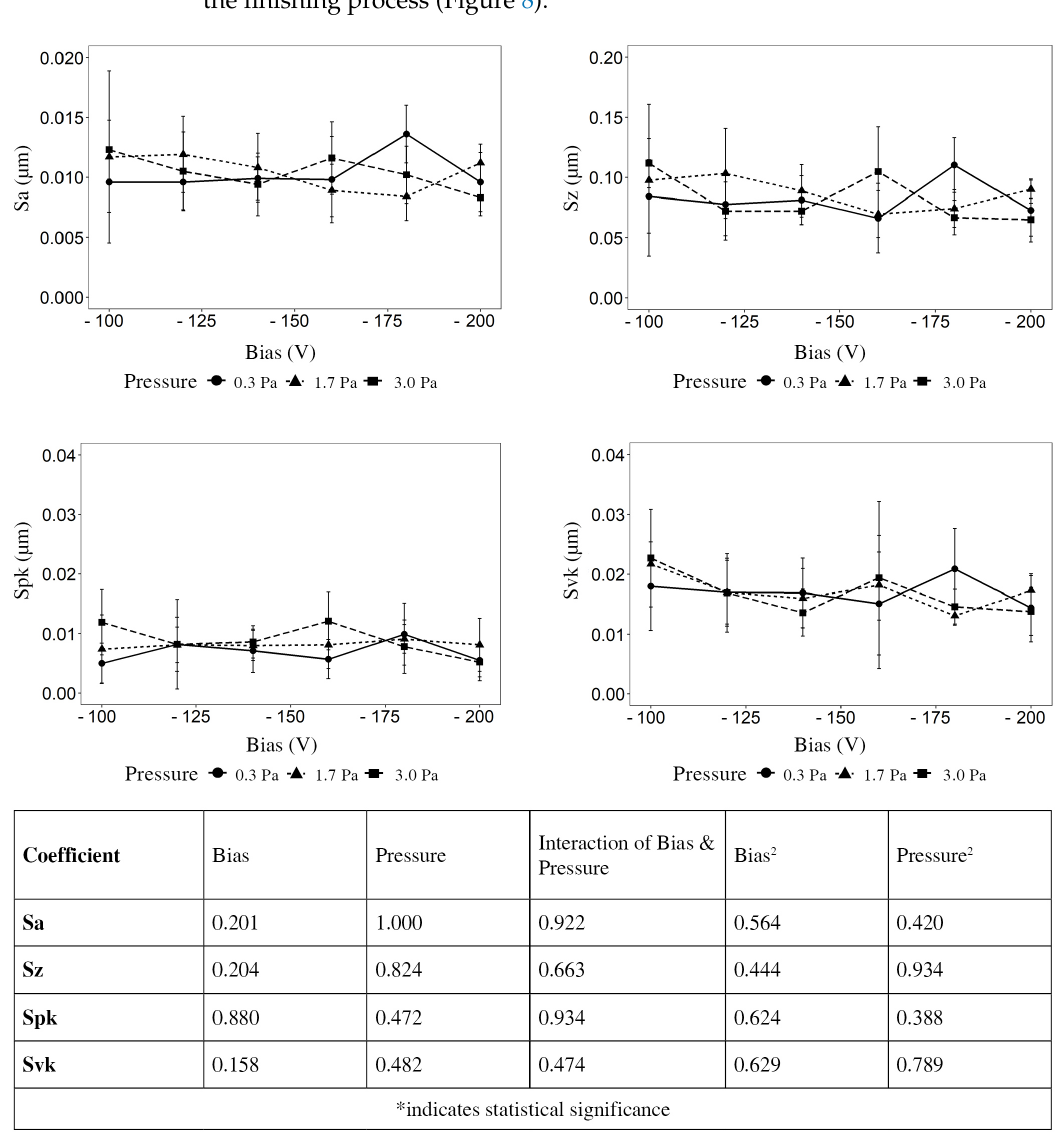
Figure 8. Scatter plot of surface roughness Sa, Sz, Spk and Svk (finished).